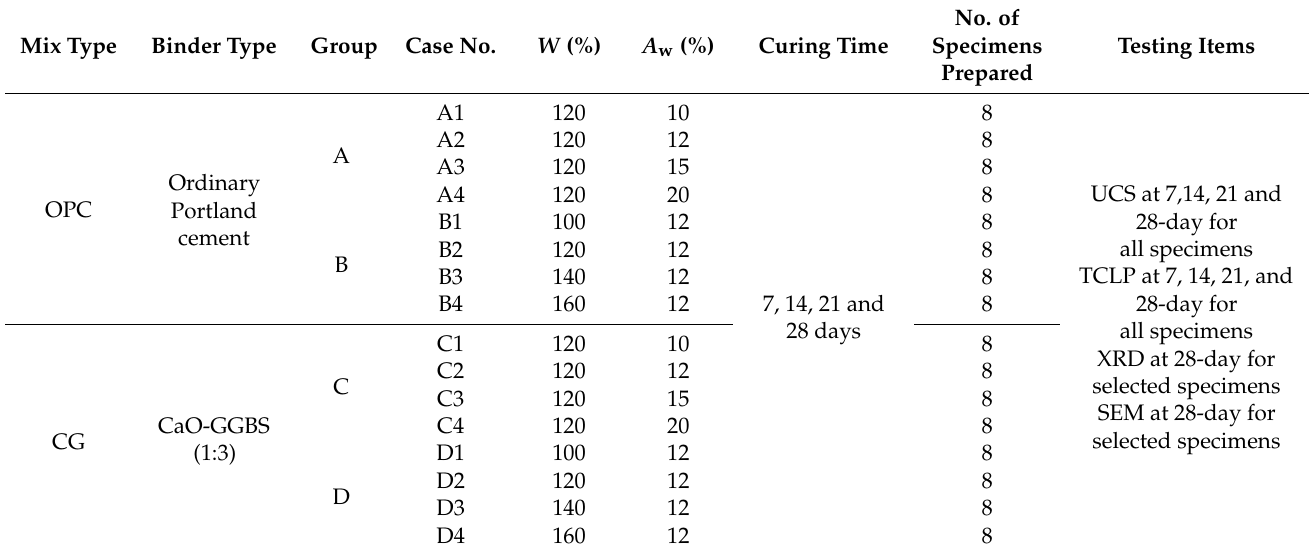
Table 3. Testing